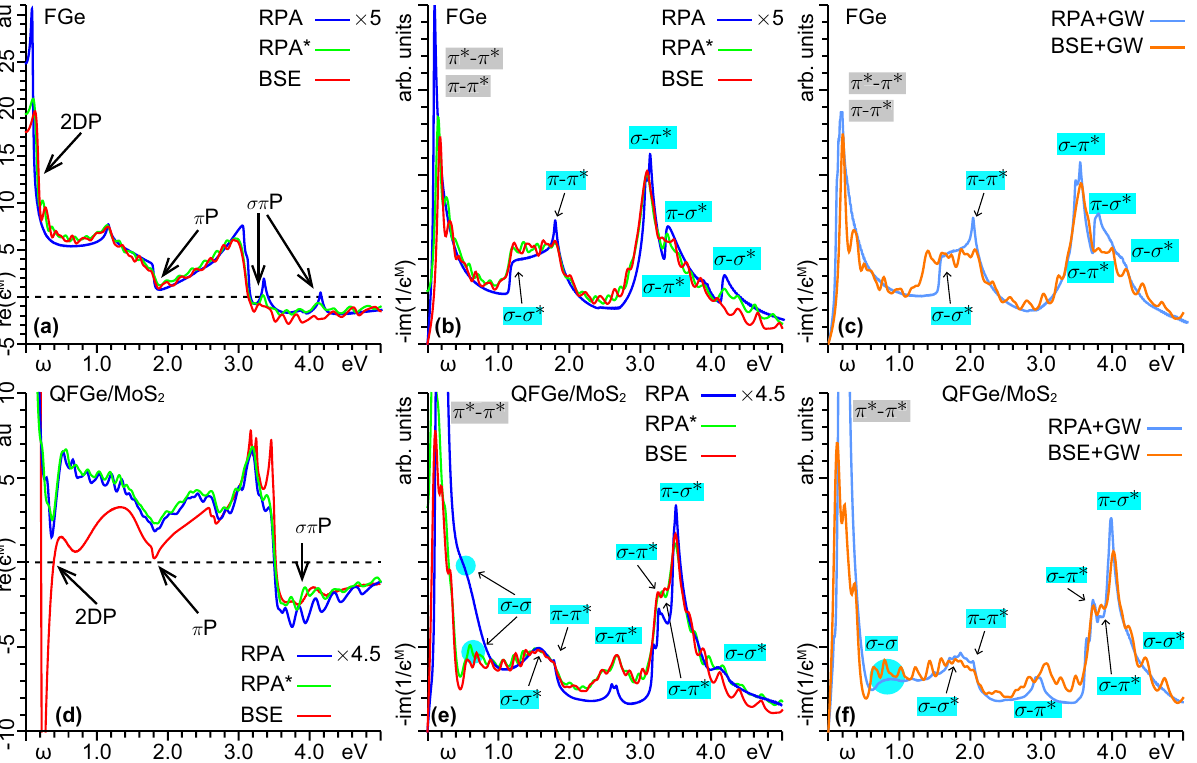
Figure 10. Macroscopic permittivity of ( a )–( c ) FGe and ( d )–( f ) QFGe on MoS 2 in intrinsic conditions 0 ), as obtained within ( a ), ( b ), ( d ), ( e ) the RPA and BSE approximations, and ( c ), ( f ) the RPA+GW and ( (cid:31) E F = BSE+GW approximations. RPA ∗ denote the RPA calculations obtained with the bare Coulomb potential and the same resolution as the BSE computations. In ( a ), ( d ), the resonant energies of the 2DP, π P and σ P are spotted in changes of sign, or attempted change of sign of re (ǫ m ) , with the linear vertical scale expressed in au. Unlike Fig. 3, the macroscopic imaginary permittivities in ( b ), ( c ), ( e ), ( f ) are given on a linear vertical scale, expressed in arb. units. The comparison of the RPA ∗ and BSE results in ( b ), ( e ) suggests that the sub-peaks in ( b ), ( c ), ( e ), ( f ), superimposed to the main intraband and interband absorption peaks, already identified within the RPA or RPA+GW treatments, are an artifact of the reduced resolution in BSE computations. On the other hand, the RPA and RPA+GW computations presented here have a much more accurate resolution on the 1 st BZ, thus giving a more reliable prediction of the FIR-NIR